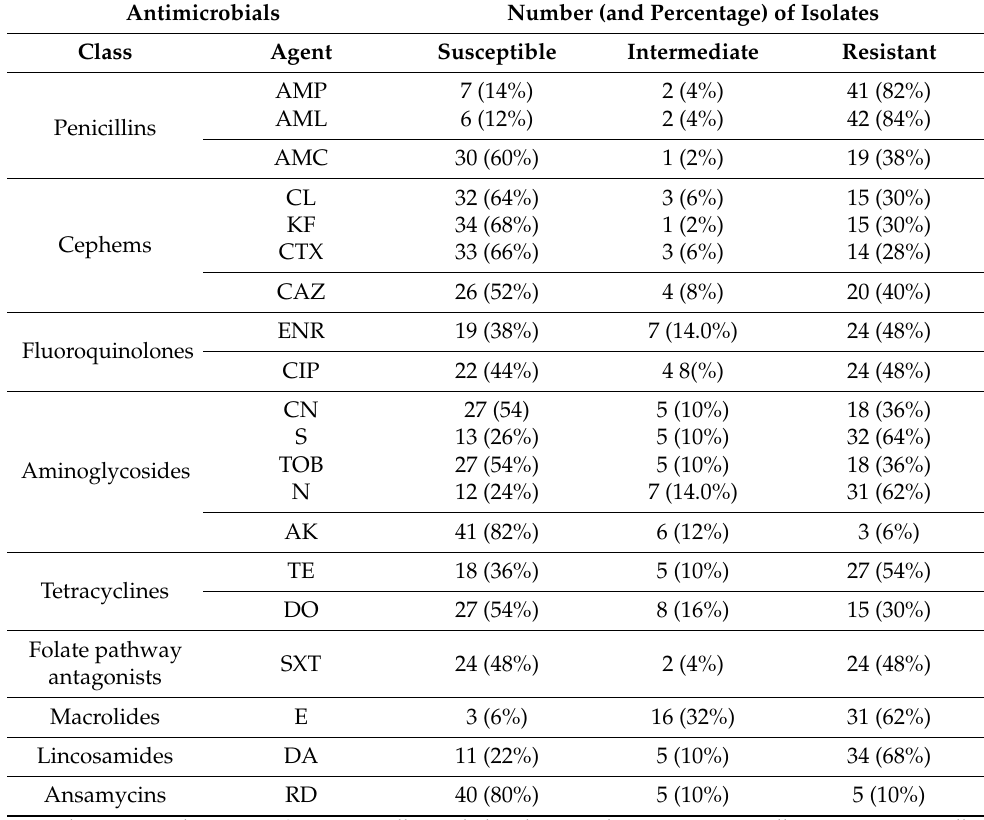
Table 3. Antimicrobial resistance detected in the examined Staphylococcus